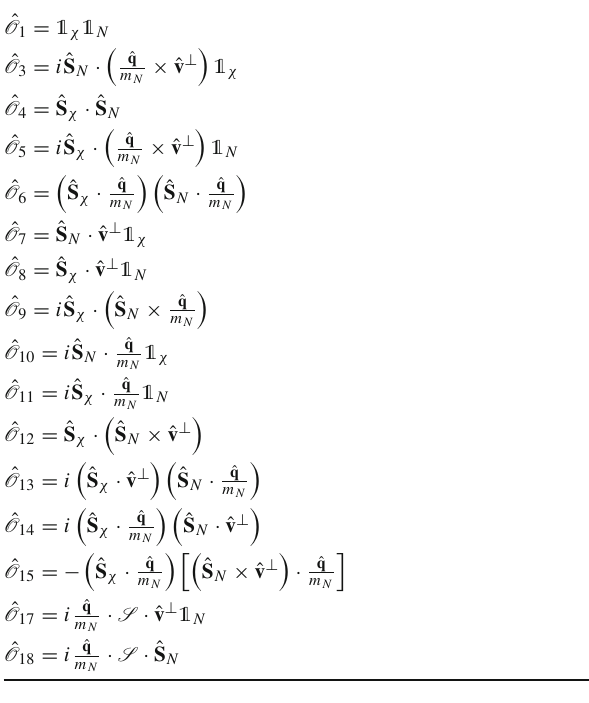
Table 1 Quantum mechanical operators defining the non-relativistic effective theory of dark matter–nucleon interactions [14]. Here we adopt the notation introduced in Sect. 2. Standard spin-independent and spin-dependent interactions correspond to the operators ˆ O 1 and ˆ O 4 , respectively. The operators ˆ O 17 and ˆ O 18 can only arise for spin 1 dark matter, and S is a symmetric combination of spin 1 polarisation vec- tors [25]. Following [14], here we do not consider the operators ˆ O i ˆ O i (see text above Eq. (2) for further details). For simplicity, we omit 16 the nucleon index in the operator